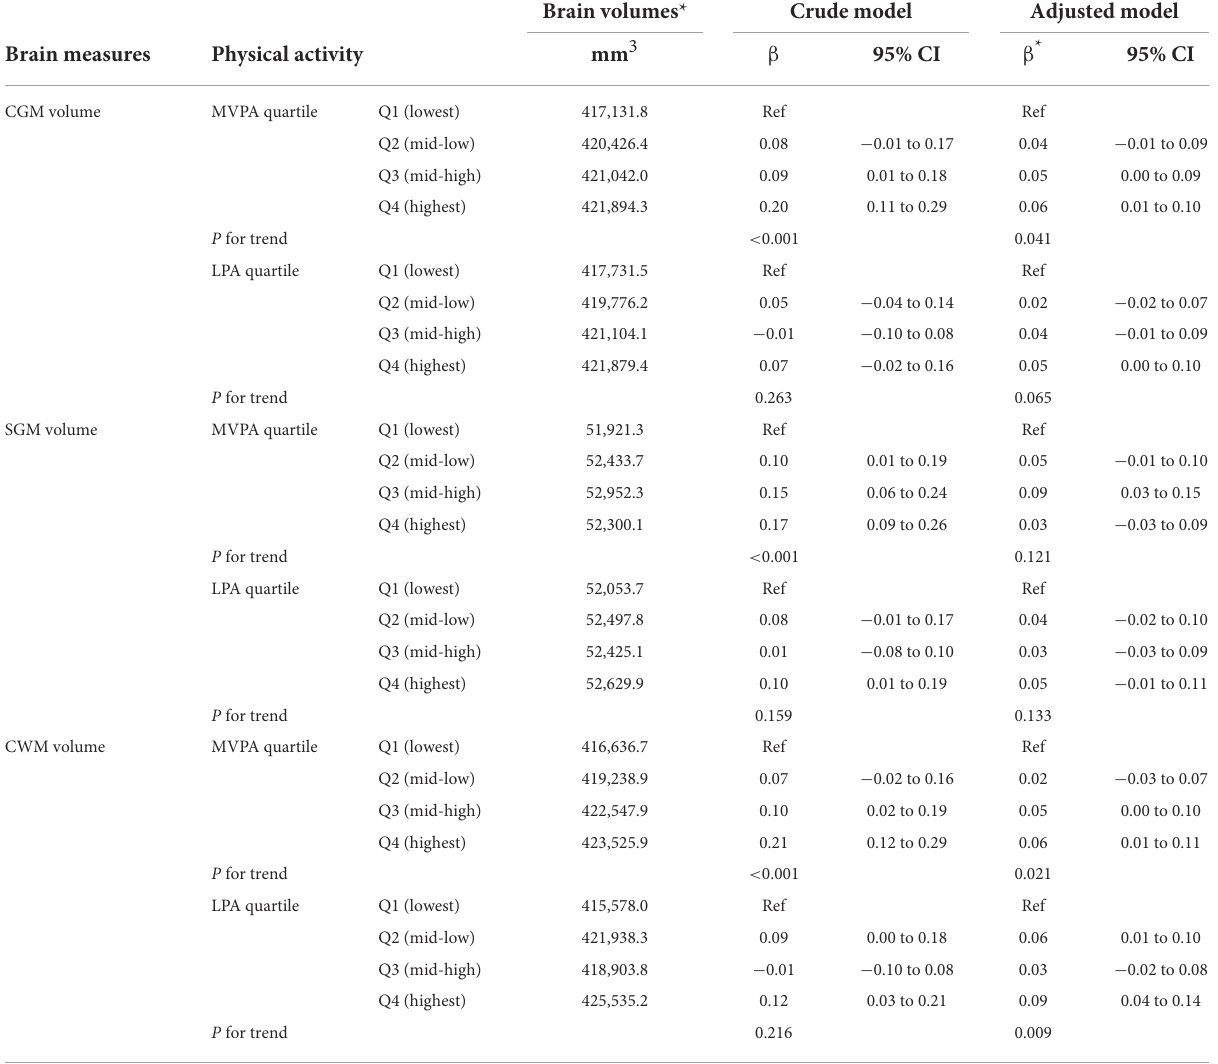
TABLE 2 Physical activity and brain volume in the overall